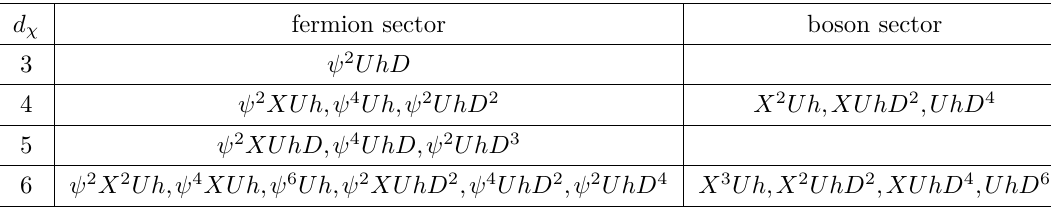
Table 1 . Operator types of HEFT up to d χ = 6 . The classes listed in this paper respect the convention that each of them contains a factor Uh since U ( x ) is used to ‘dress’ building blocks and h ( x ) can be used freely in the operator constructions, as explained in section 4. Because the spurion T is of no chiral dimension, thus we do not write them in the classes explicitly, while it should be understood that each class here contains all possible sub-classes with different numbers of